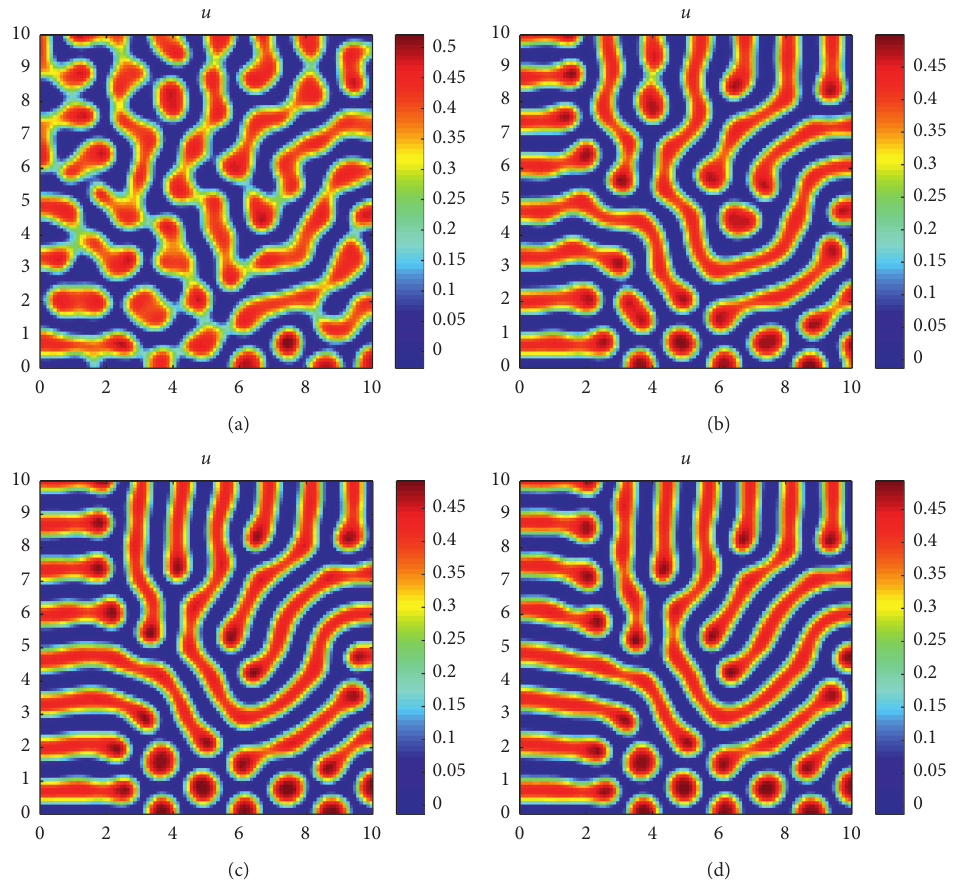
Figure 4: Stripe patterns obtained with model [1] for A � 0 and τ � 0 . 25. Time: (a) t � 100, (b) t � 500, (c) t � 2000, and (d) t �